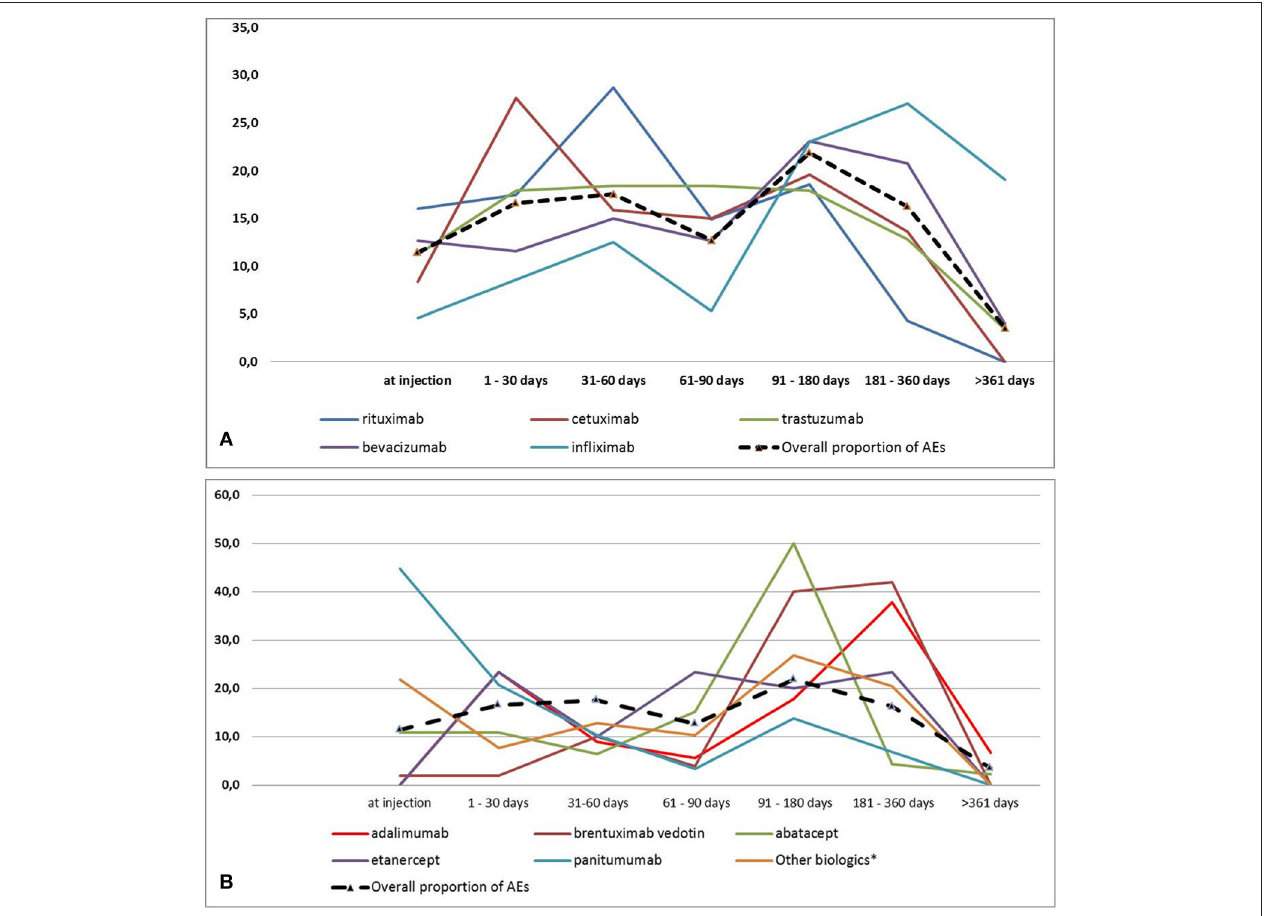
FIGURE 2 | (A,B) Adverse events distribution by biotech drugs and follow-up